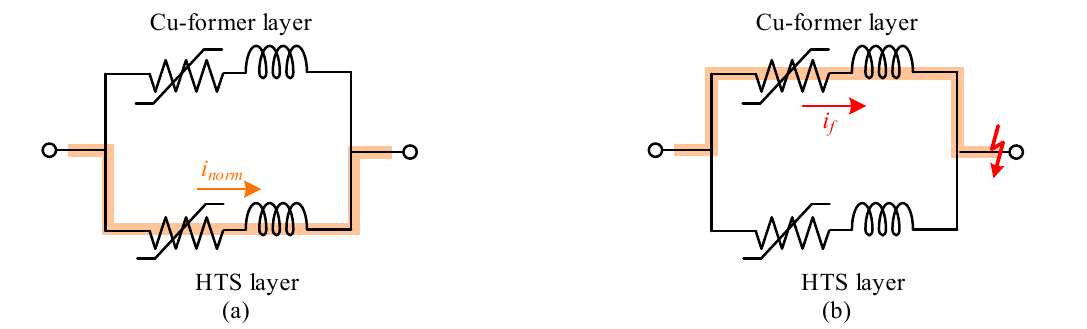
Figure 2. Operation characteristics of the HTS cable: ( a ) current flow into each phase in the normal state; and ( b ) current flow into each phase in the transient state.